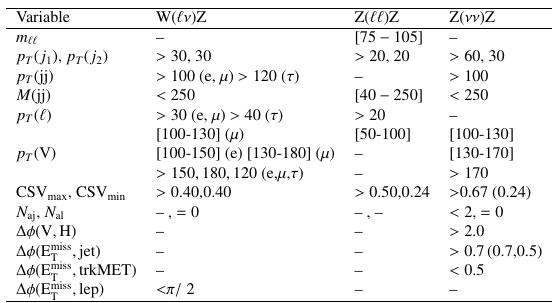
Table 1. Selection criteria for the samples used in the BDT training in each channel. The values listed for kinematical variables are in units of